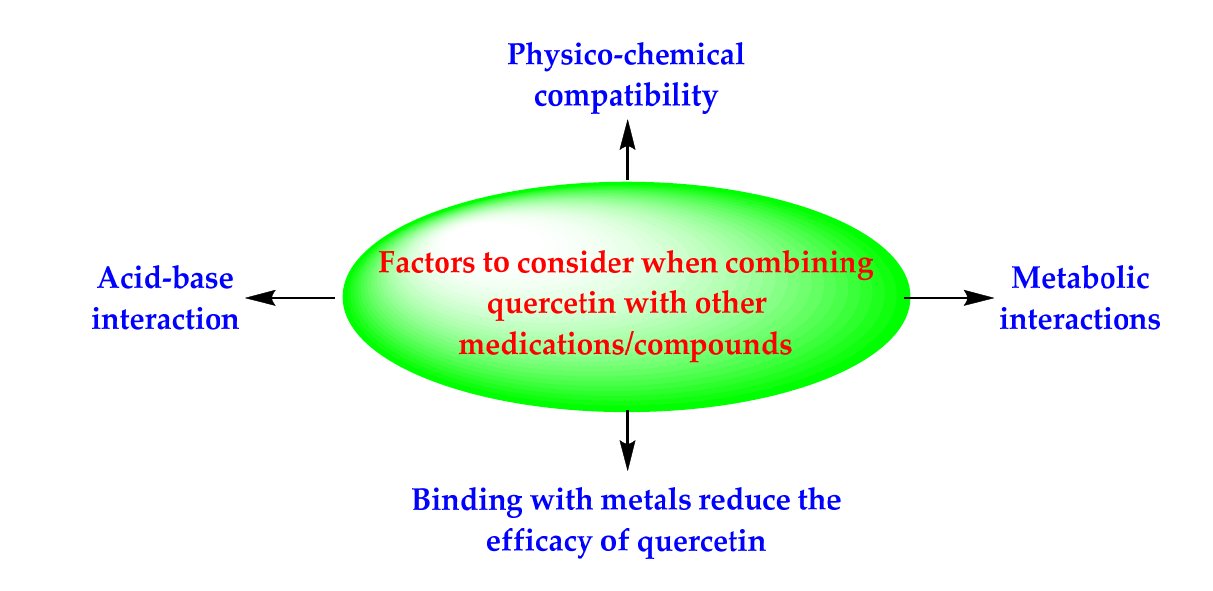
Figure 6. Factor that may affect the quercetin-based drug combinations.